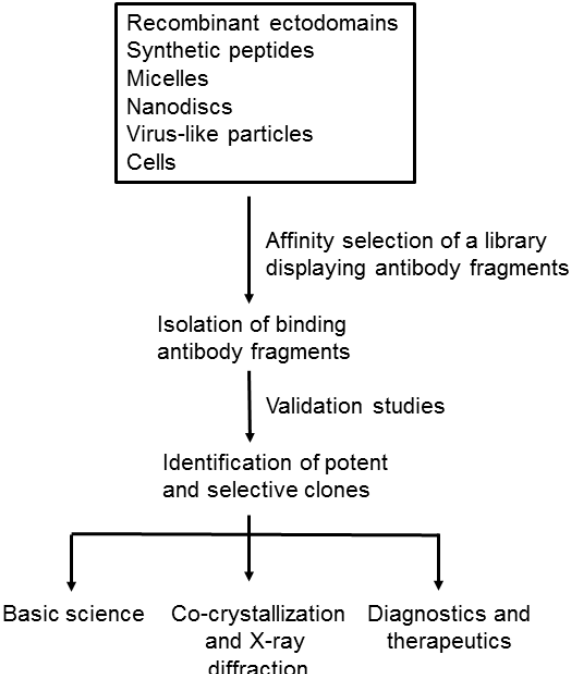
Figure 1. Workflow for generating recombinant antibodies to membrane proteins. Purified membrane proteins, presented in different formats, are mixed with a library of virions displaying antibody fragments. The antibody binders are selected by affinity selection and the encoded antibody fragments are characterized biochemically. The most potent and selective binders are chosen for various applications, such as basic science, crystallography, diagnostics and therapeutics.